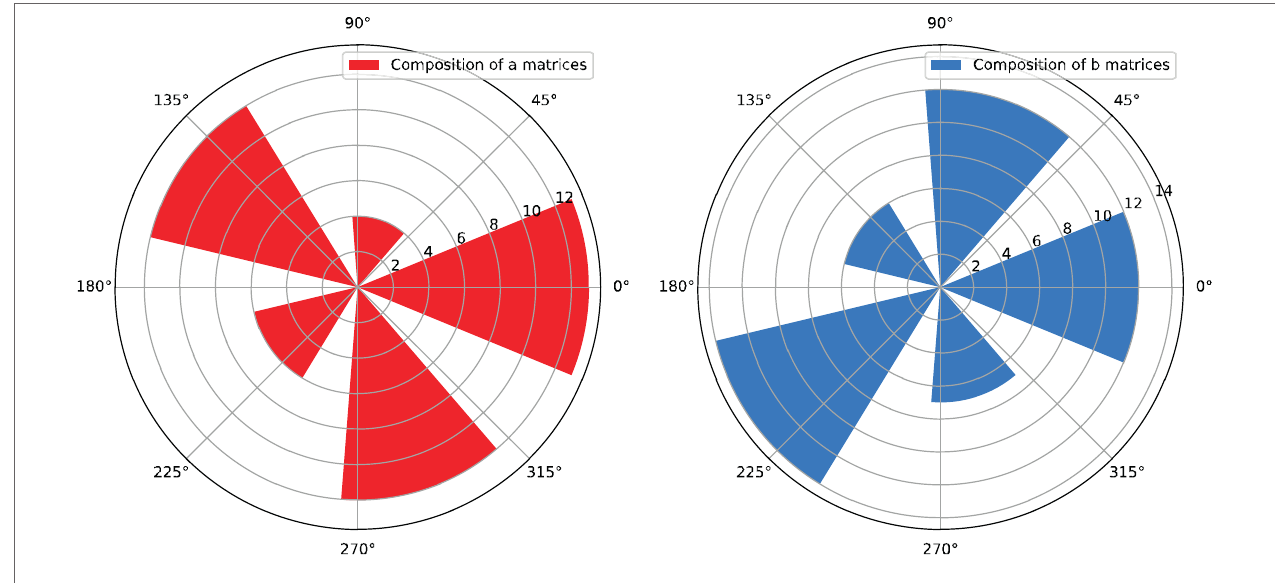
FIGURE 5 | Distribution of teacher teaching relevance data